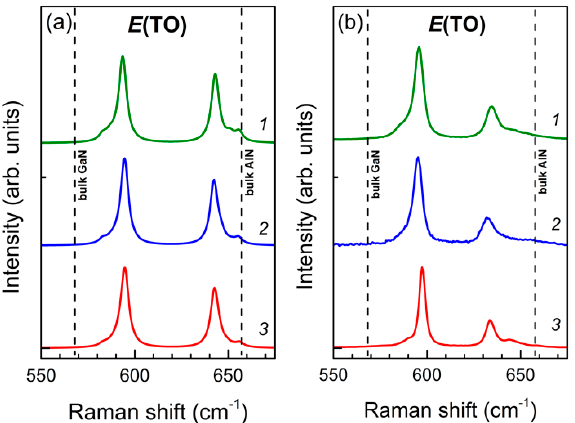
Figure 5. Calculated ( a ) and experimental ( b ) Raman spectra of (GaN) m /(AlN) n SLs in the z ( xy ) z scattering geometry in the region of E (TO) modes, m / n : 1 —4/4, 2 —6/6, 3 —8/8.